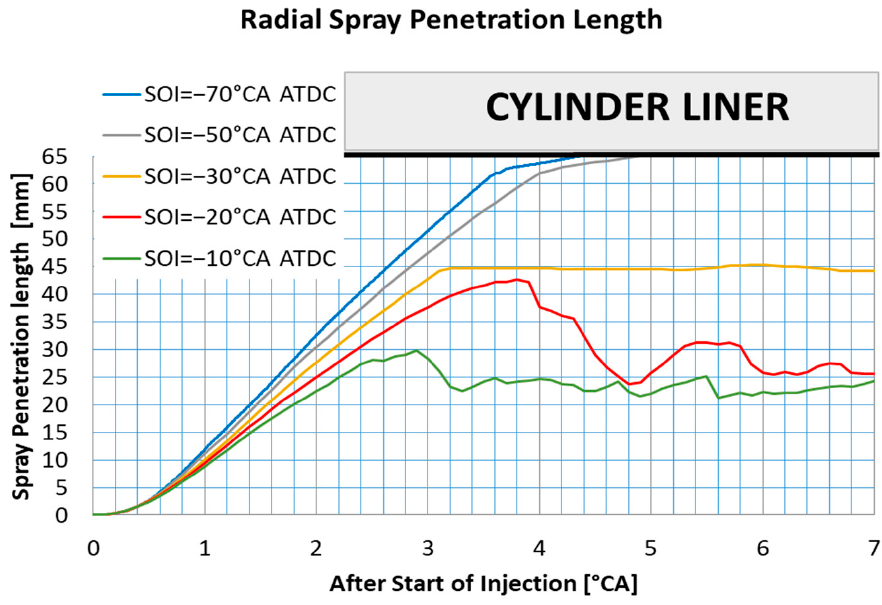
Figure 18. STPL in radial direction according to °CA after SOI for various SOI timings. On the other hand, for the late SOI timings, SOI of − 30, − 20, − 10 °CA ATDC, sprays do not interact with the cylinder liner. In late injection cases, STPL suddenly begins to drop with SOIgn. During combustion, evaporation rates of the fuel droplets increase rap- idly as the gas temperature rises significantly, which decreases STPL.